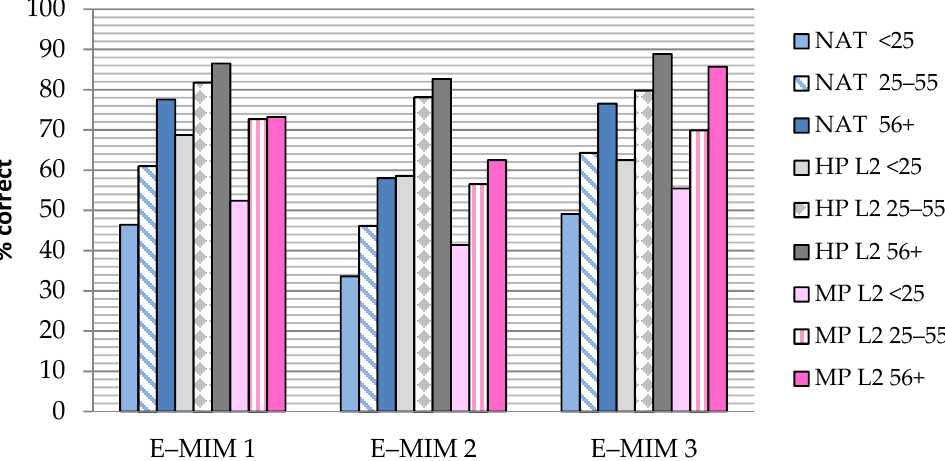
Figure 2. Percent correct scores for adult participants by language background and age on E-MIM (all subtests).